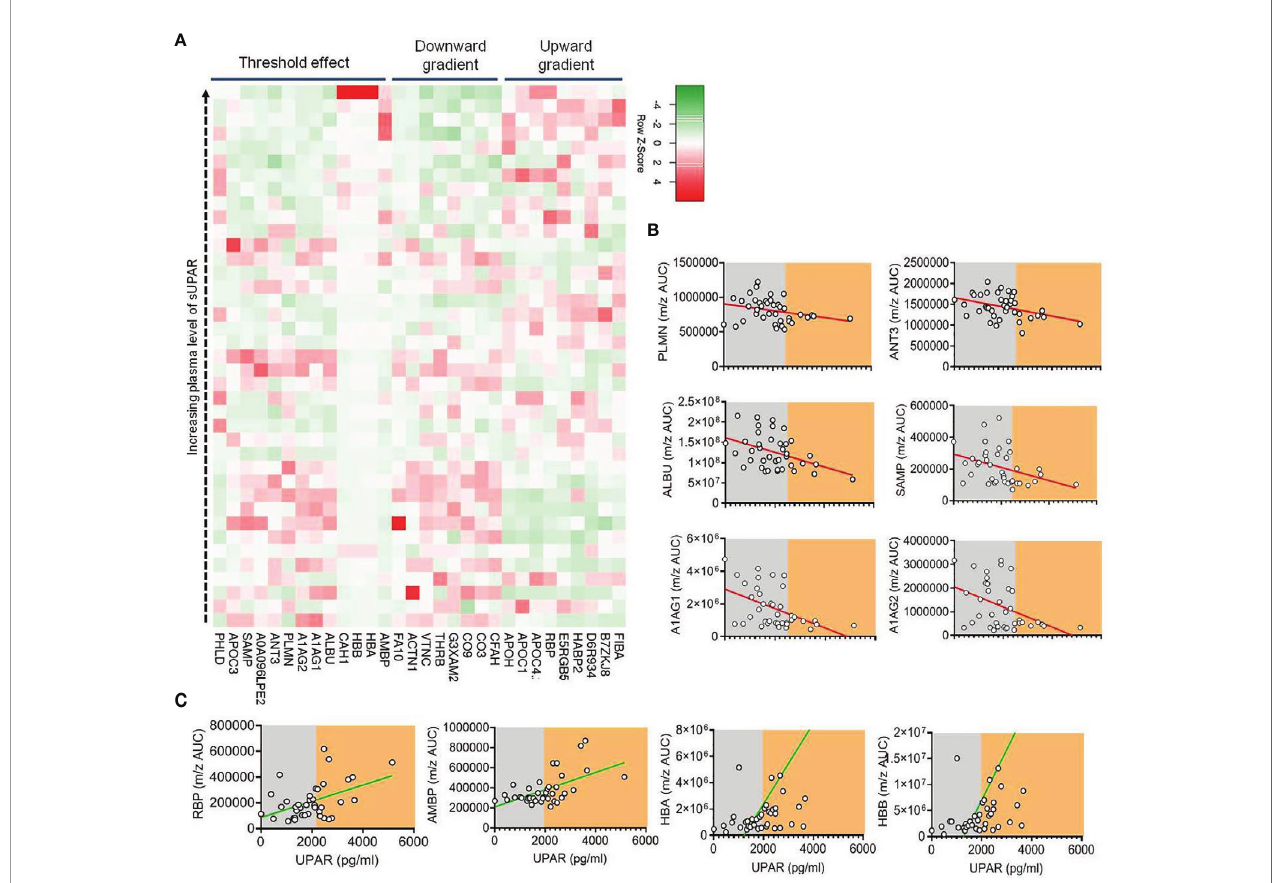
FIGURE 5 | Proteomics analysis of plasma from patients with different plasma levels of suPAR. (A) Heatmap depicting the relation between the concentration of suPAR and the quantities of selected proteins (those which show signi fi cant correlations indicated, in plasma of Covid-19 patients). Each square represents one protein of one speci fi c patient. The proteins have been categorized into three groups based on their pattern of expression — those which show a gradual increase with increase in suPAR, those which show a gradual decrease with increase in suPAR, and those which show sudden but signi fi cant change at a threshold plasma concentration of suPAR. (B, C) Representative line graphs for correlation between plasma suPAR concentration and area under curve of m/z peaks of proteins showing threshold downregulation (B) , viz., PLMN, ANT3, ALBU, SAMP, A1AG1, and A1AG2, and proteins showing threshold upregulation (C) , viz., RBP, AMBP, HBA, and HBB, to demonstrate the threshold effect, shown by arbitrary shaded